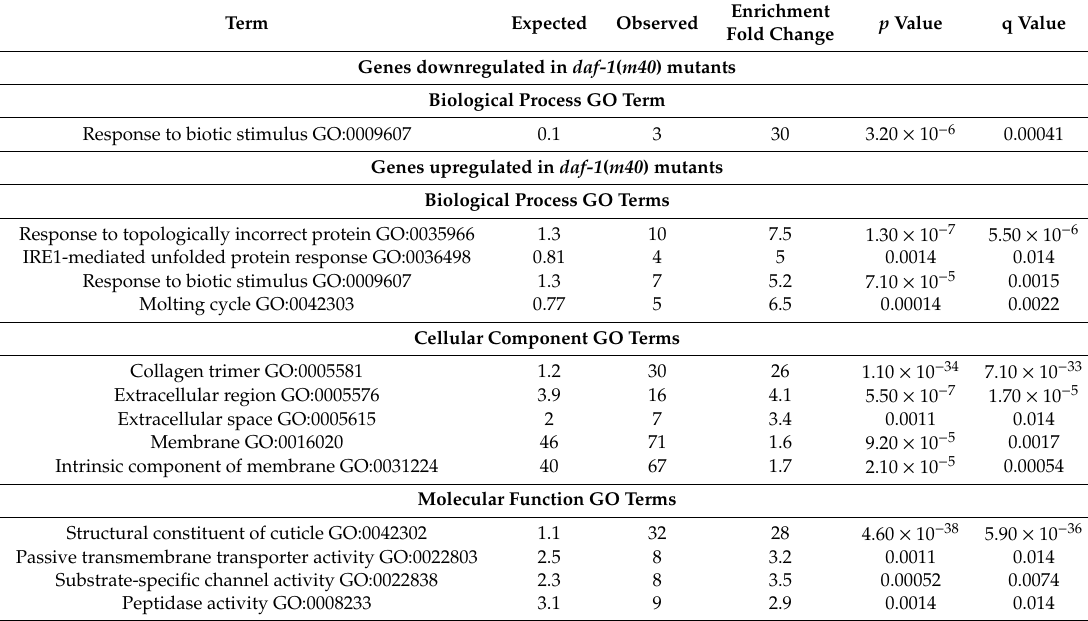
Enrichment p Value q Value Fold Change